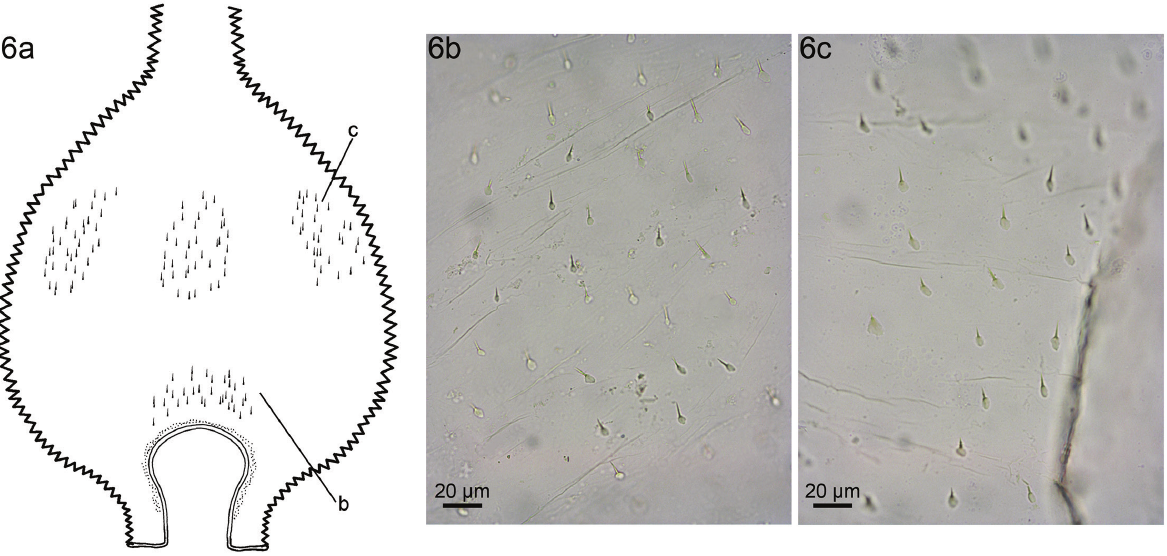
Figure 6. Cyrilliotermes angulariceps . (a) Schematic drawing of P1 showing arrangement of spines. (b, c) Photomicrographs: (b) Reduced spines located in proximal region. (c) Spines in distal